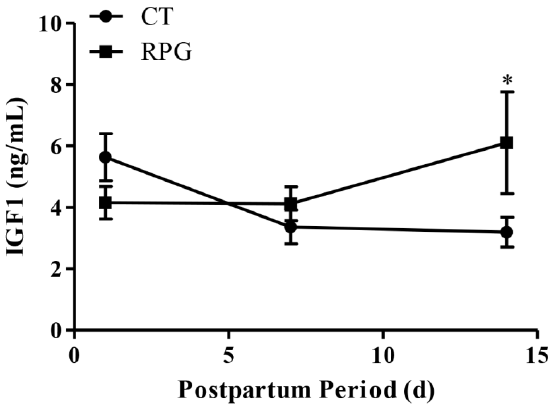
Figure 1. Plasma concentrations of IGF1 in post-natal cows in the RPG and the CT group during the experimental period. Data are presented as the means ± SD. Compared to control diet: * p < 0.05.